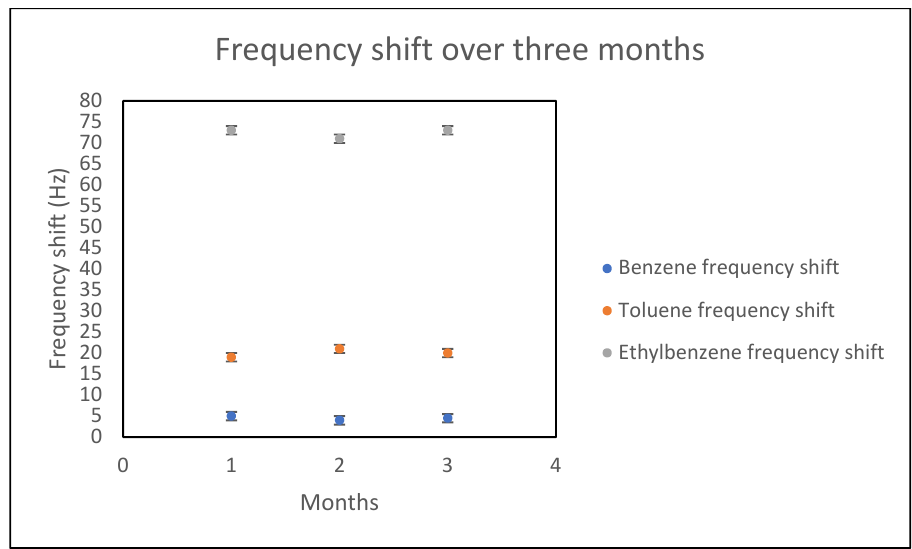
Figure 7. Frequency shifts for benzene, toluene and ethylbenzene in PS–BS (15%) film over three months.